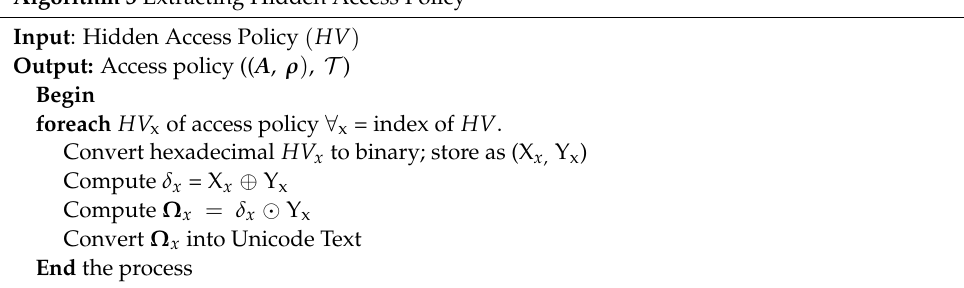
Algorithm 3 Extracting Hidden Access